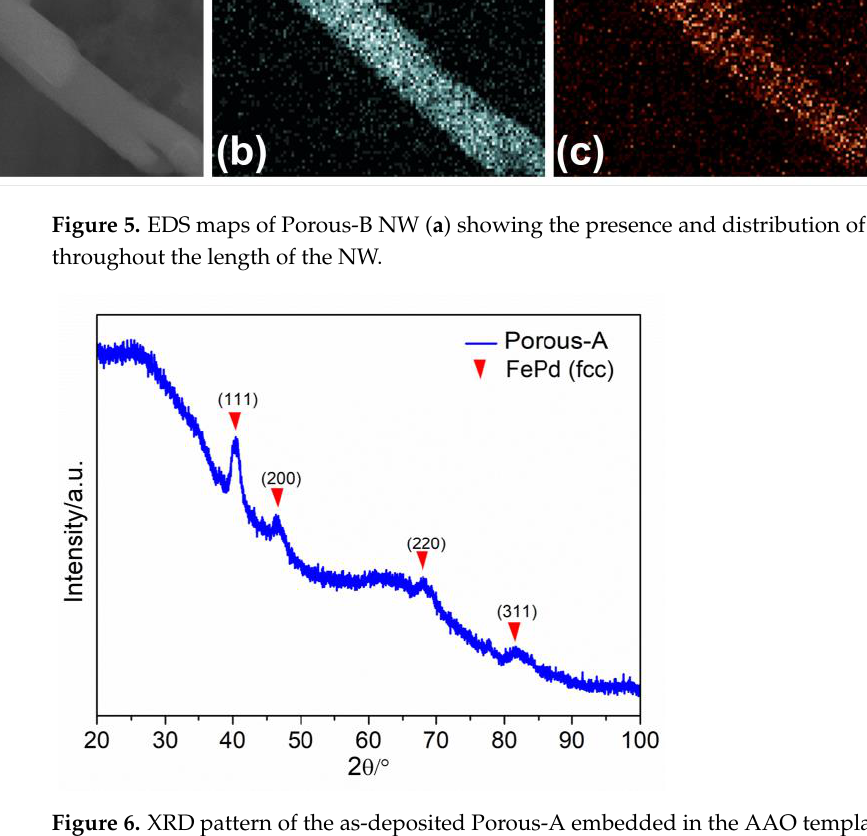
Figure 6. XRD pattern of the as-deposited Porous-A embedded in the AAO template.